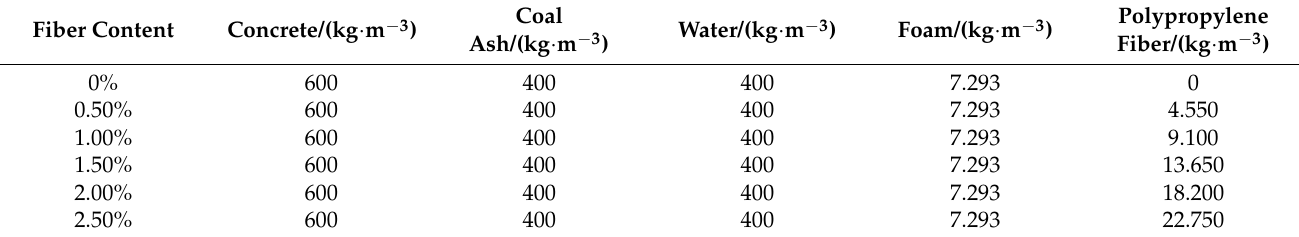
Table 1. The proportions of fiber foam concrete.